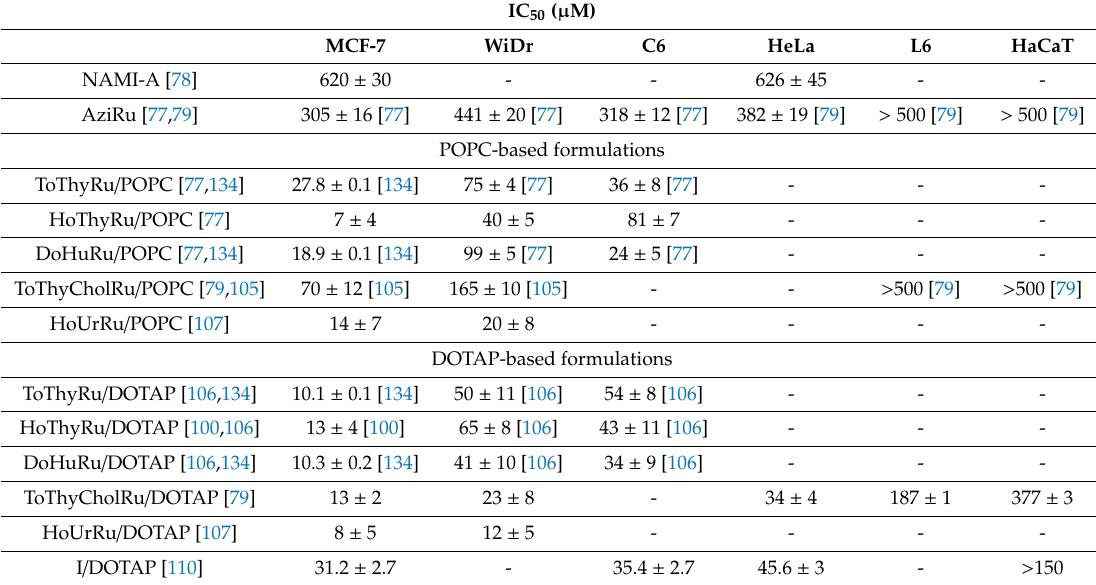
Table 1. IC 50 values ( µ M) relative to AziRu and to the e ff ective ruthenium concentration inserted in the Ru(III)-incorporating POPC- and DOTAP-based liposomes in the indicated cell lines following 48 or 72 h of incubation in vitro. IC 50 values are reported as mean ±